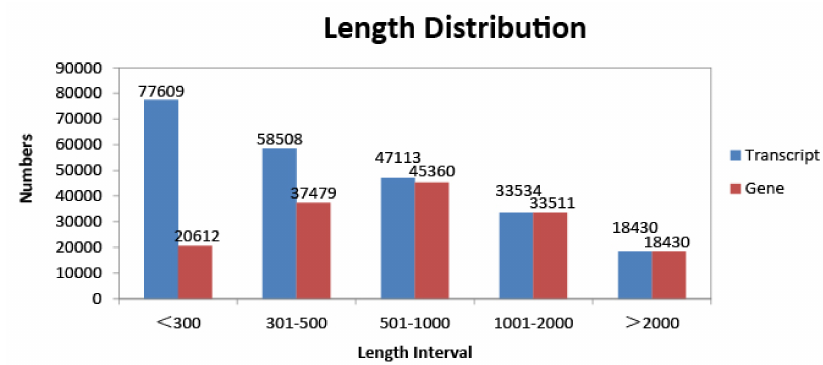
Figure 2. Length distribution of D. sinicus transcripts and unigenes.